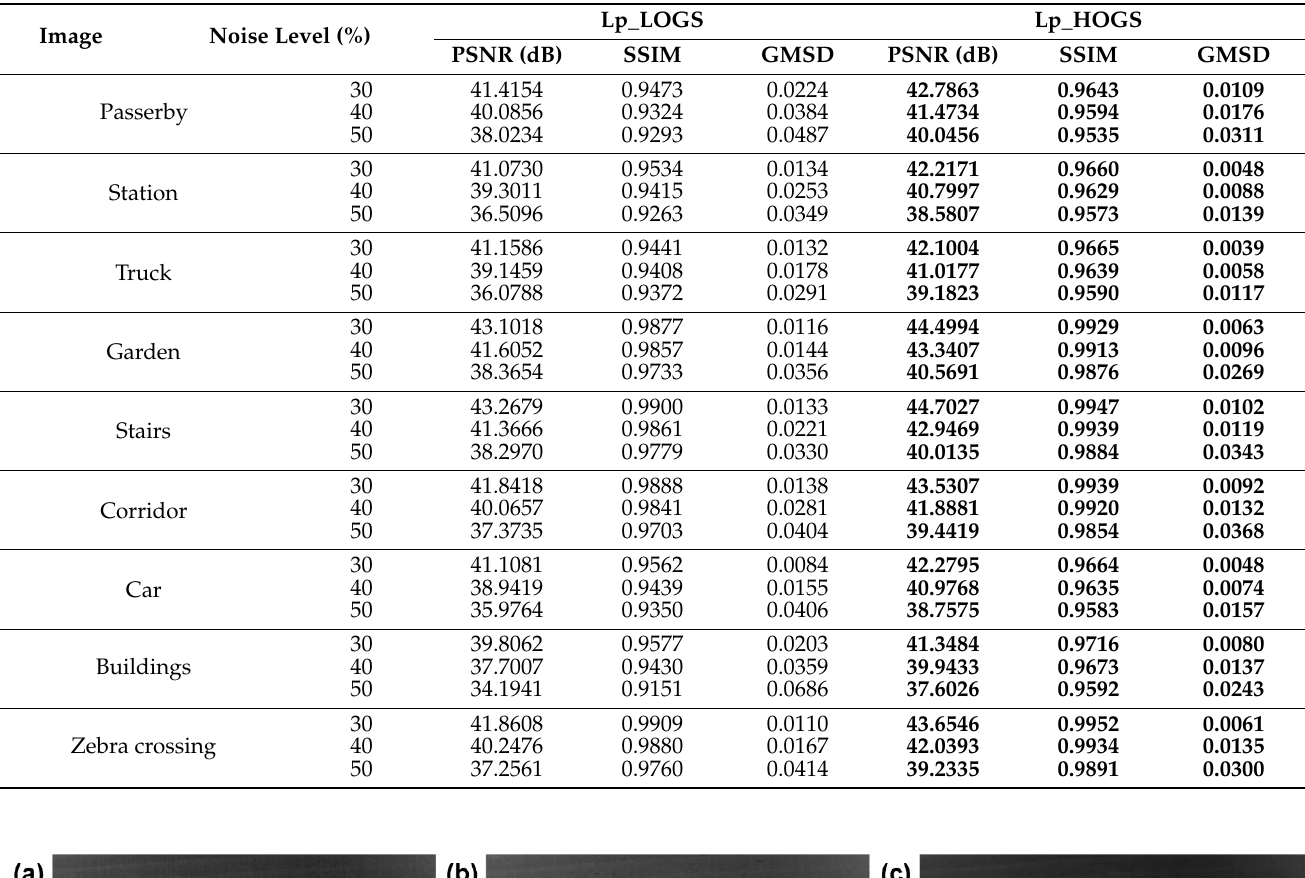
Table 3. The Lp_HOGS and Lp_LOGS deblurring effects on images with the 7 × 7 motion blur. The optimal indicators under each condition are denoted in bold.